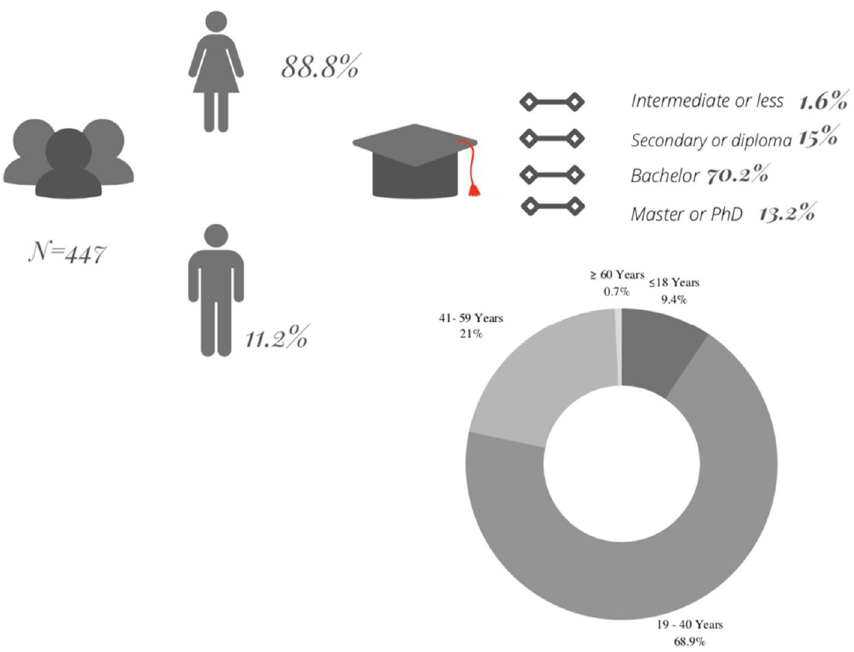
Figure 1. Demographics of the survey participants